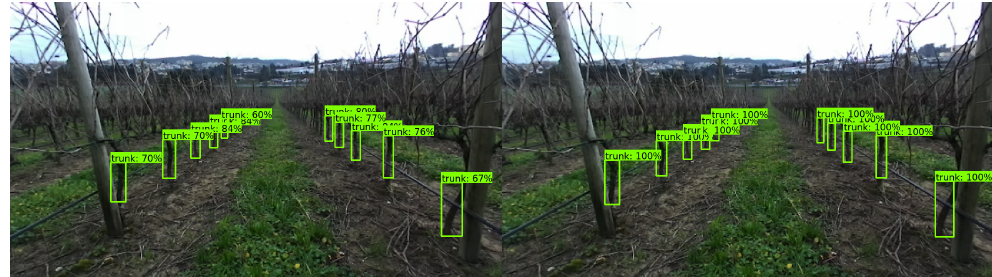
Figure 10. Detection results using SSD MobileDet Edge